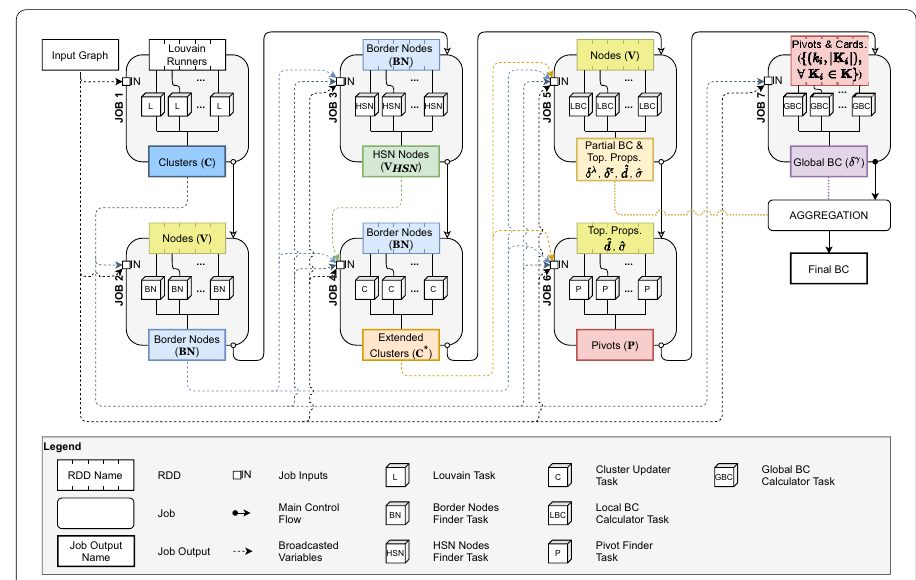
Fig. 5 Map-reduce, Spark-based description of E1C-FastBC. The main execution flow is represented by solid arrows, while dashed ones represent broadcast variables. Jobs and tasks are depicted as rounded rectangles and cubes, respectively. RDDs are shown as non-rounded